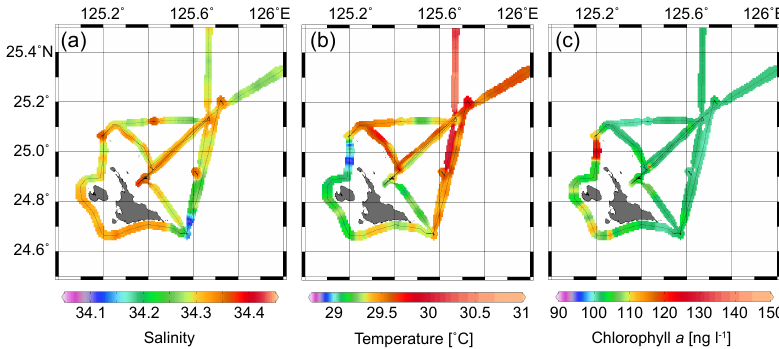
Figure 4. Surface (a) salinity, (b) temperature, and (c) chlorophyll a during the KT-09-17 cruise.